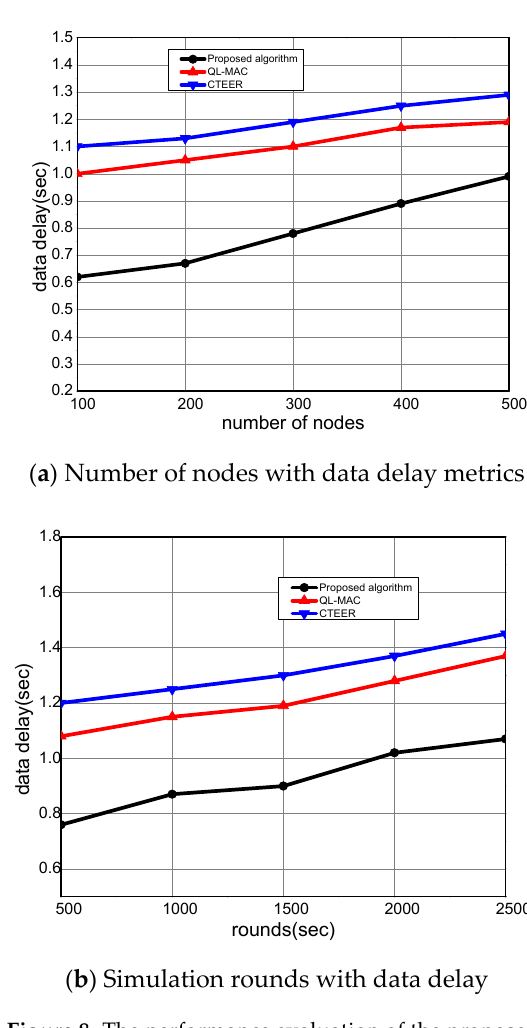
Figure 8. The performance evaluation of the proposed algorithm compared to QL-MAC and CTEER for data delay.